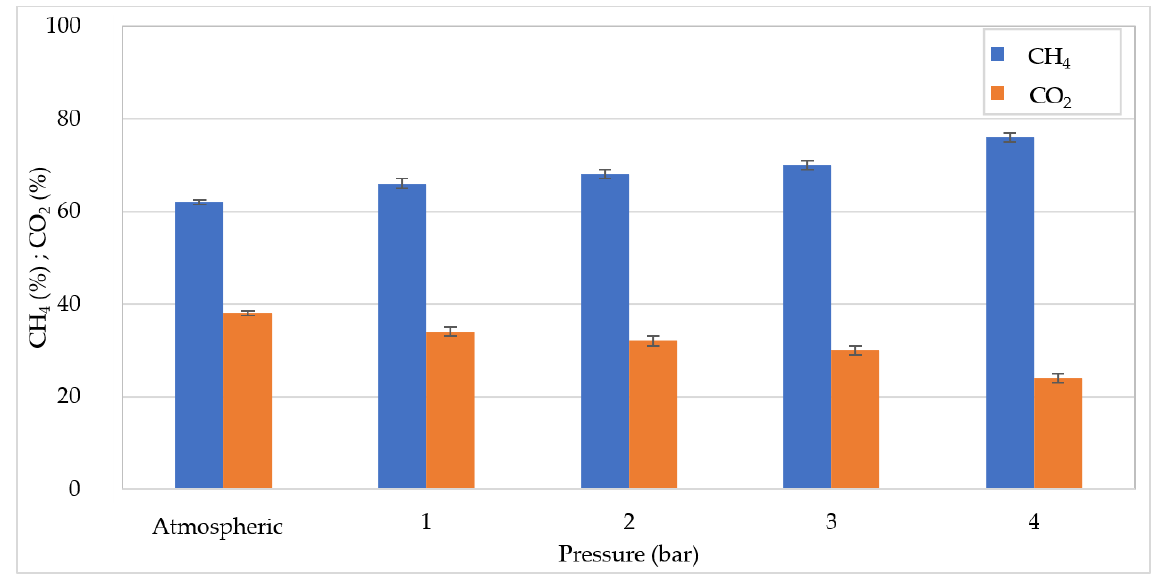
Figure 5. CH 4 and CO 2 percentages at increasing pressures for organic load rate (OLR) of 30 kg COD /m 3 d.